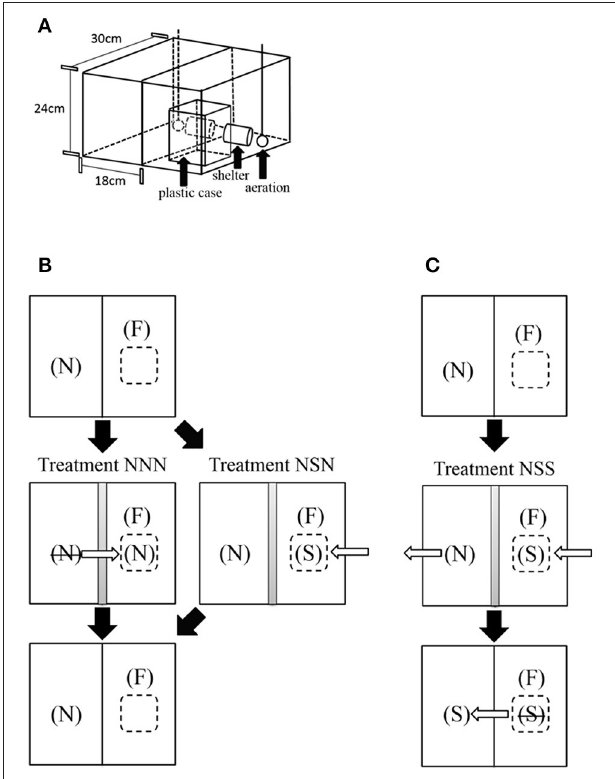
FIGURE 1 | Experimental tanks and experiment procedures. (A) Two experimental tanks were set up side-by-side and a clear plastic case was placed in one tank. The plastic shelter tube and aeration stone are shown. The focal fish was in the tank with the plastic case. (B) Focal fish (F), dear neighbor (N), and stranger (S). Treatment NNN involved N in its tank, N intruding in the center of F’s tank (inside the small case), and N returned to its tank. Treatment NSN shows N in its tank, then S in the case in tank F while N remains in its tank. Arrows depict the exchange of the fish. During the presentation of fish in the small case inside F’s tank, an opaque sheet is placed between the two tanks. (C) Focal fish (F), dear neighbor (N), and stranger (S). Treatment NSS shows the process with N in its tank, S intruding at the center of F’s tank (inside the small case), and S placed in N’s tank.